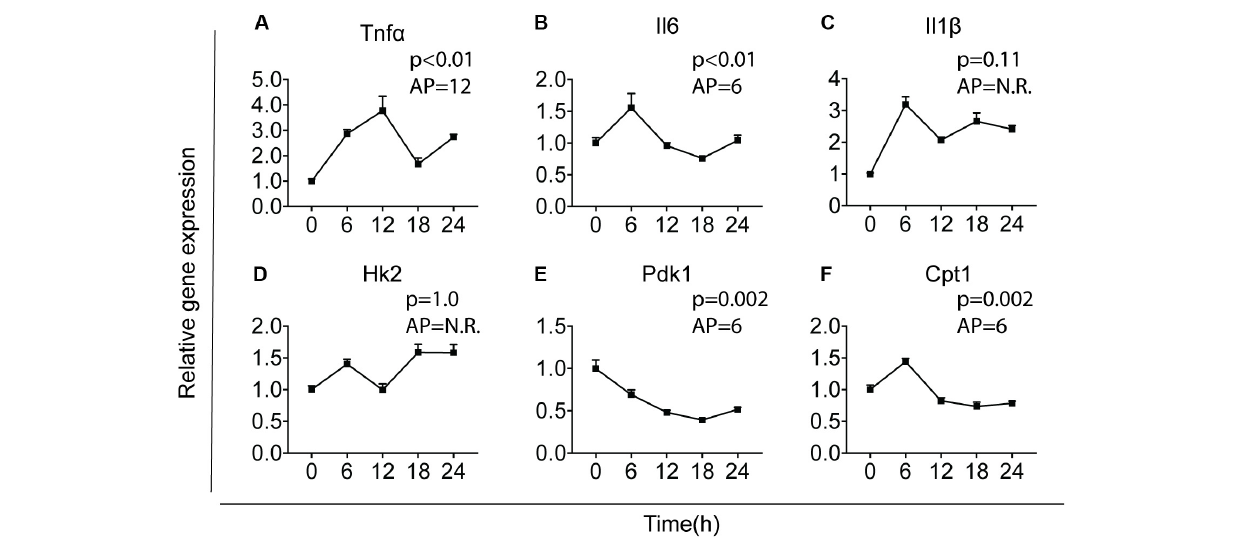
FIGURE 1 | Major cytokines and metabolic genes are rhythmically expressed in microglia. Relative gene expression of major cytokines and metabolic genes was measured in primary microglia. After synchronization by dexamethasone for 2 h, cells were cultured and harvested at the indicated post-synchronization time points (T; n = 6 per group, per time point). Rhythmic expression is signified by a p -value of less than 0.05 and can be found for Tnf (A) , Il6 (B) , Pdk1 (E) , and Cpt1 (F) . The expression of Il1 (C) and Hk2 (D) was not rhythmic. The acrophase of the curve is not relevant (N.R.) if data does not fit a curve. Data are presented as means ± SEM and statistical significance was determined using JTK_Cycle software.